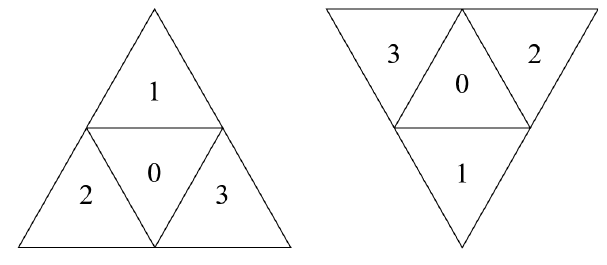
Figure 4. Modified direction encoding method.